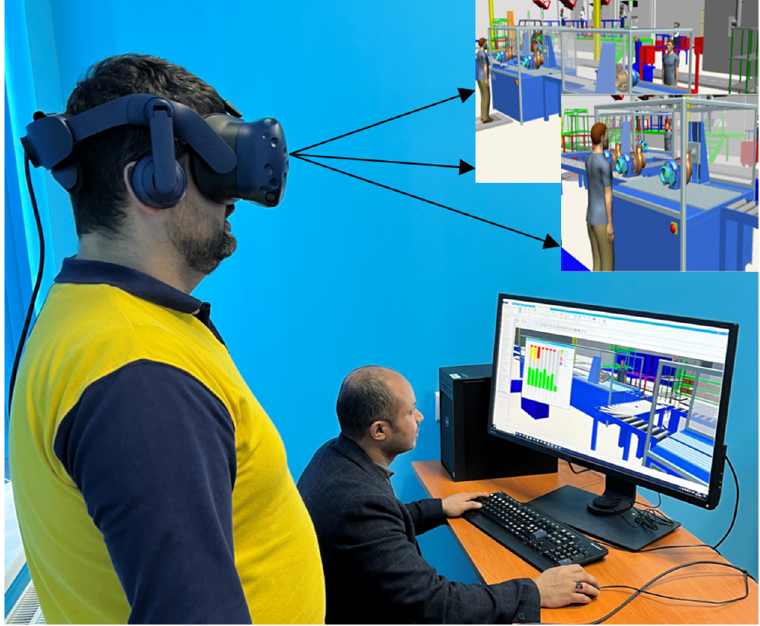
Figure 14. Virtual reality technology shows selected production process in digital factory.